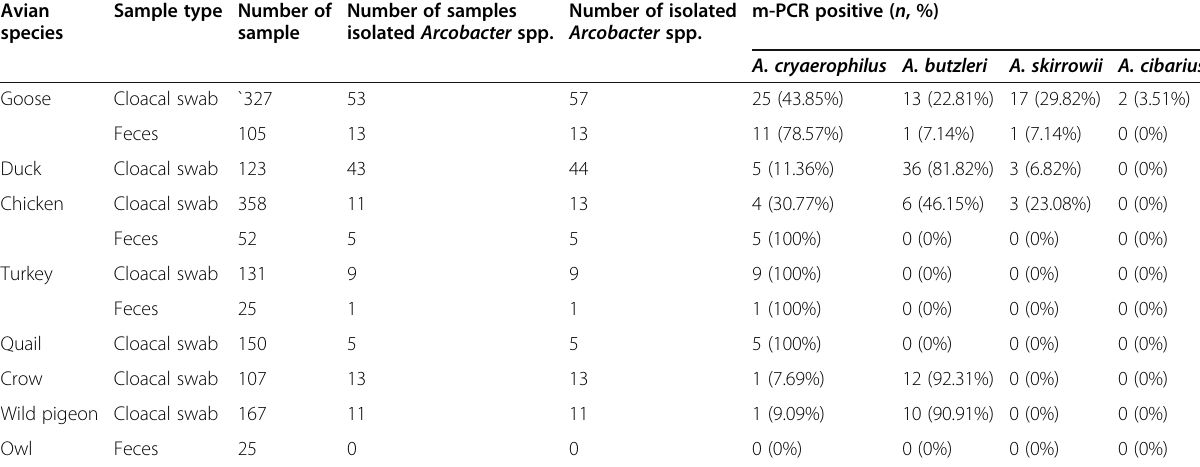
Table 1 Distribution of Arcobacter species identified at the result of m-PCR performed in cloacal swab and feces samples of domestic poultry and wild birds Avian Sample type Number of species sample